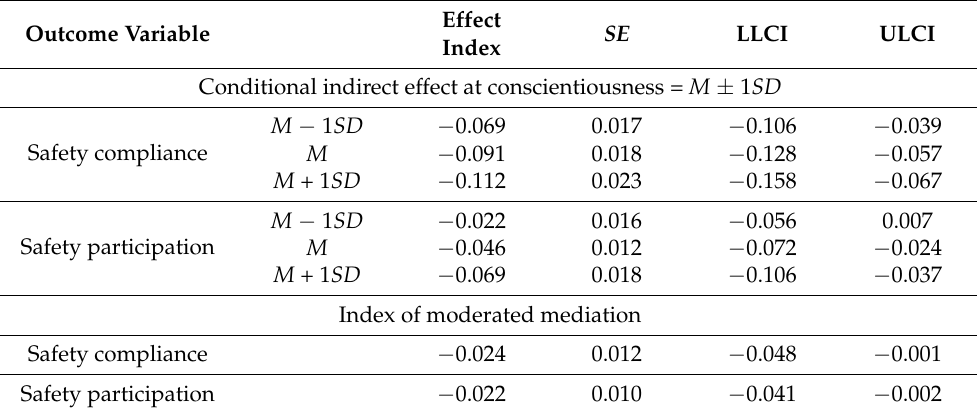
Table 4. Moderated mediation results for safety motivation across levels of conscientiousness on safety compliance and safety